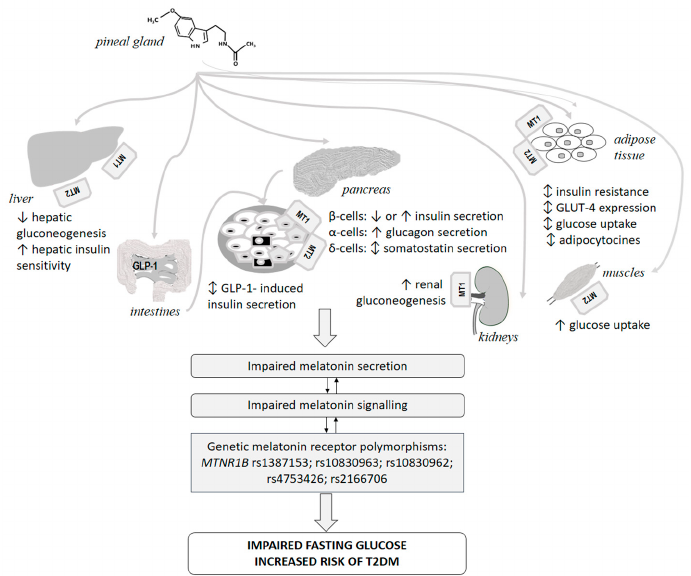
Figure 2. Melatonin and carbohydrate disturbances—pathophysiological mechanisms. T2DM—diabetes mellitus type 2; GLP-1—glucagon like peptide 1; MT1—melatonin receptor type 1; MT2— melatonin receptor type 2; ↑ —increase; ↓ —decrease; ↕ —modulate.